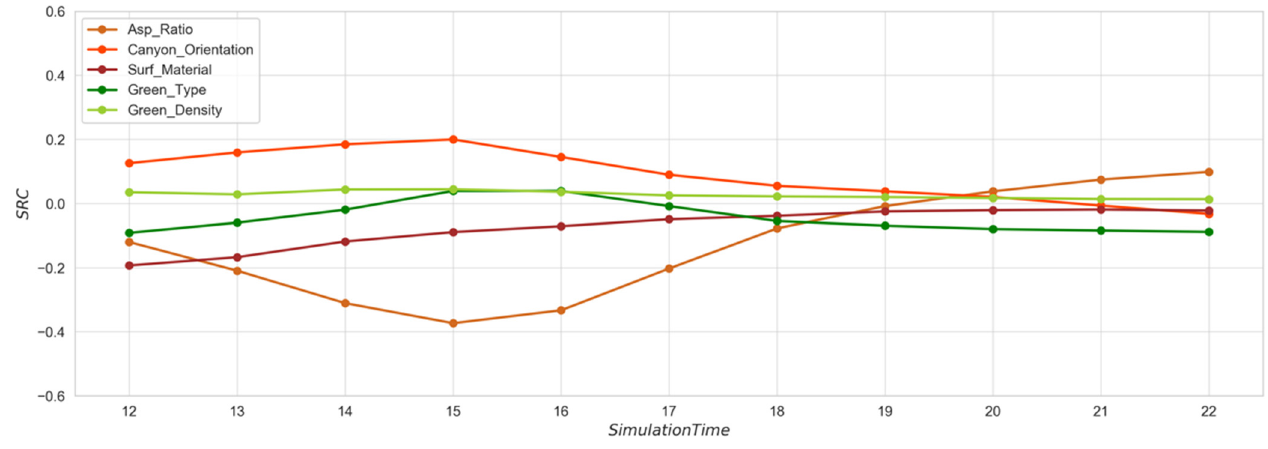
Figure 4. The effect magnitude of physical and vegetation parameters on changing air temperature during simulation hours (From 12:00 to 22:00). Table 2. p -values estimate ranges for the SRC estimates of air temperature at each timestep.